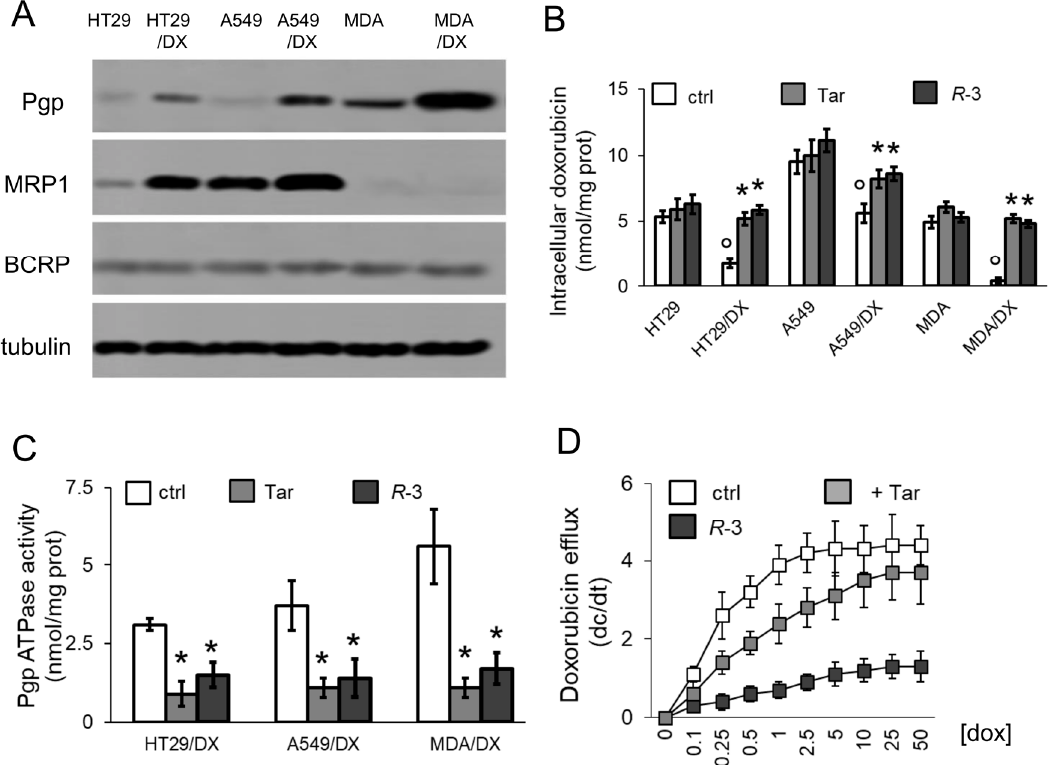
Figure 1. R -3 increases doxorubicin intracellular content by inhibiting Pgp activity. ( a ) Immunoblotting of the indicated proteins in human colon cancer HT29 cells, non-small cell lung